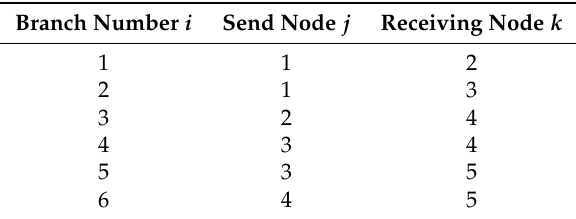
Figure 1. Example of a connected electrical grid. Table 1. Node